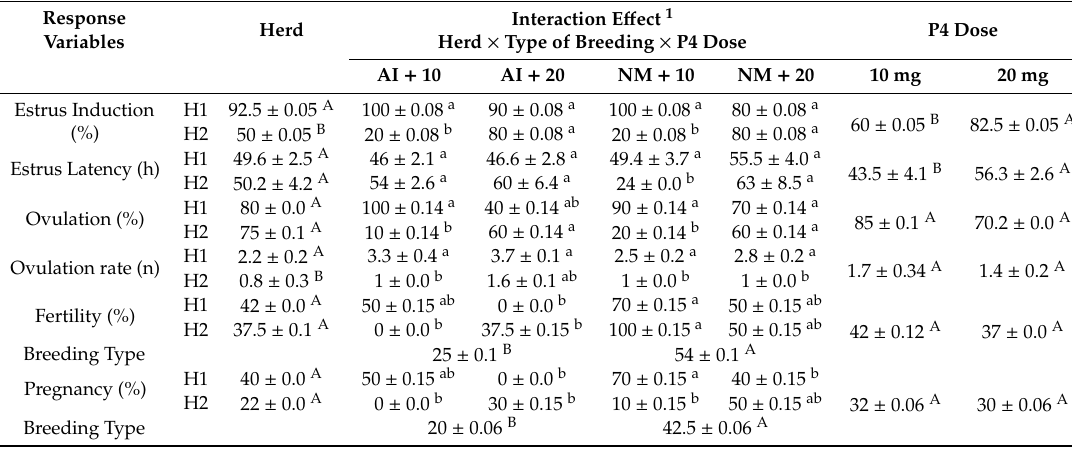
Table 1. Least square means for estrus induction (%), estrus latency (h), ovulation (%), ovulation rate (units), fertility (%), pregnancy (%), and the breeding x P4 dose interaction in adult anestrous crossbred (Saanen-Alpine-Nubian x Criollo) goats subjected to an ultra–short P4 & eCG based estrus induction protocol and breed using natural mating or artificial insemination in two commercial goat herds during the seasonal anestrous (March) in Mexico (25 ◦